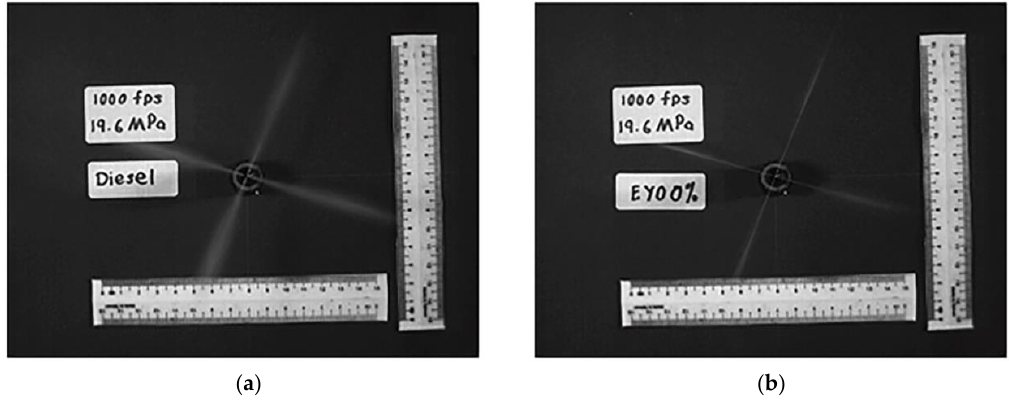
Figure 6. Injection spray pattern between ( a ) diesel fuel and ( b ) palm oil biofuels.